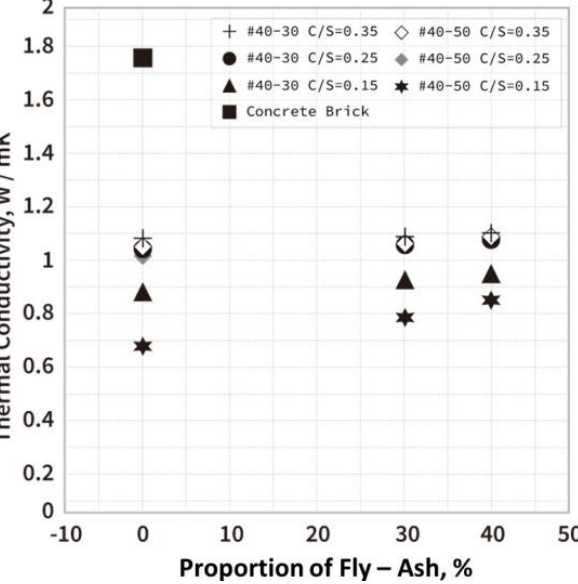
Figure 12. Thermal conductivity of EAF oxidizing slag specimens in three ratio settings.